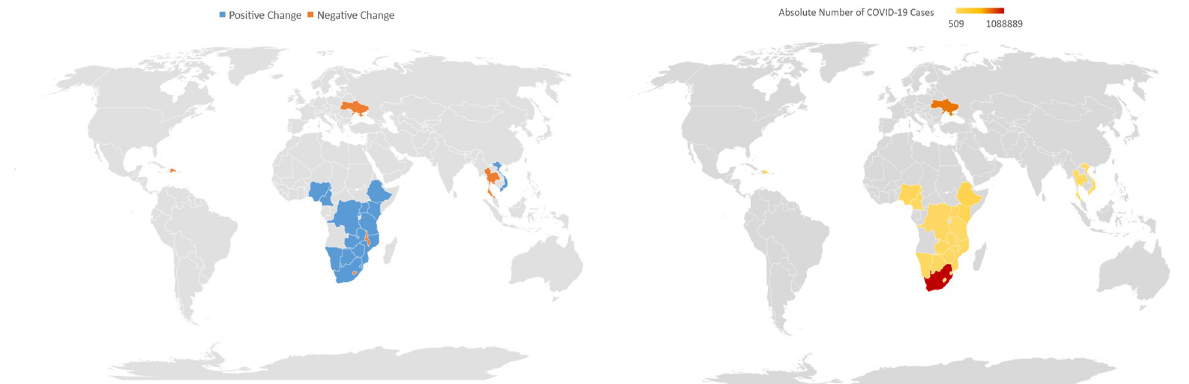
Fig 1. Uptake of pre-exposure prophylaxis in all populations (right) and incidence of COVID-19 (left), by country. a. Percent change in uptake of pre-exposure prophylaxis in all populations from the pre-COVID to COVID periods, by country (right). B. Cumulative COVID-19 cases by country, March 2020 –July 2021 (left). Data source: https://covid19.who.int/ [16]; Maps were created using Microsoft Excel version 2102.